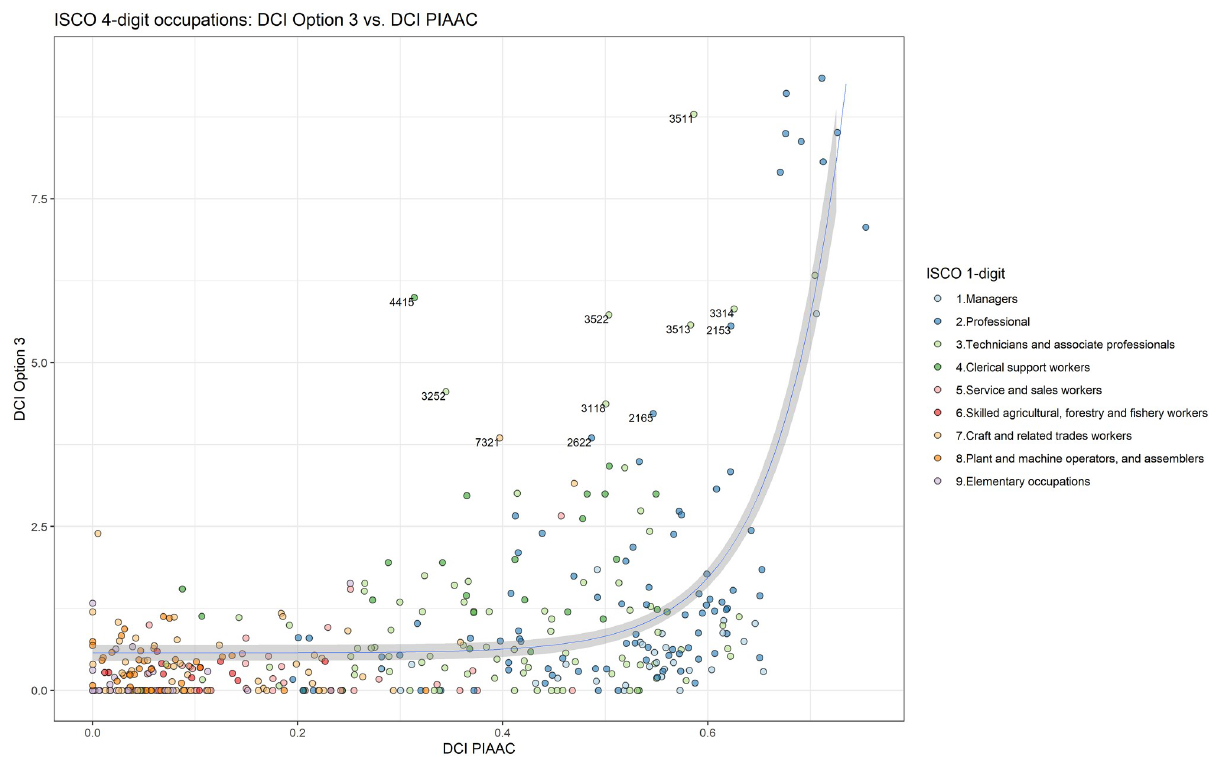
Fig 7. Scatter plot of Option 3 and DCI PIAAC: ISCO-08 4-digit occupations. Note: the labelled occupations indicate those that have a very high ESCO-based DCI compared to the PIAAC-based DCI such as ‘Information and Communications Technology Operations Technicians’ (3511), ‘Filing or Copying Clerks’ (4415), ‘Telecommunications Engineering Technicians’ (3522), or ‘Pre-press Technicians’ (7321).